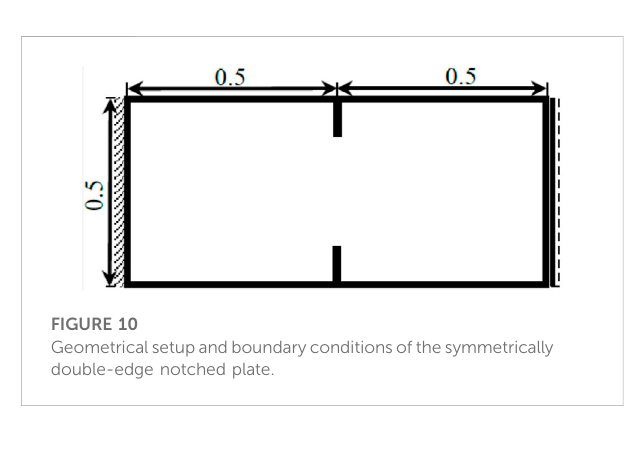
FIGURE 10 Geometricalsetupandboundaryconditionsofthesymmetrically double-edge notched